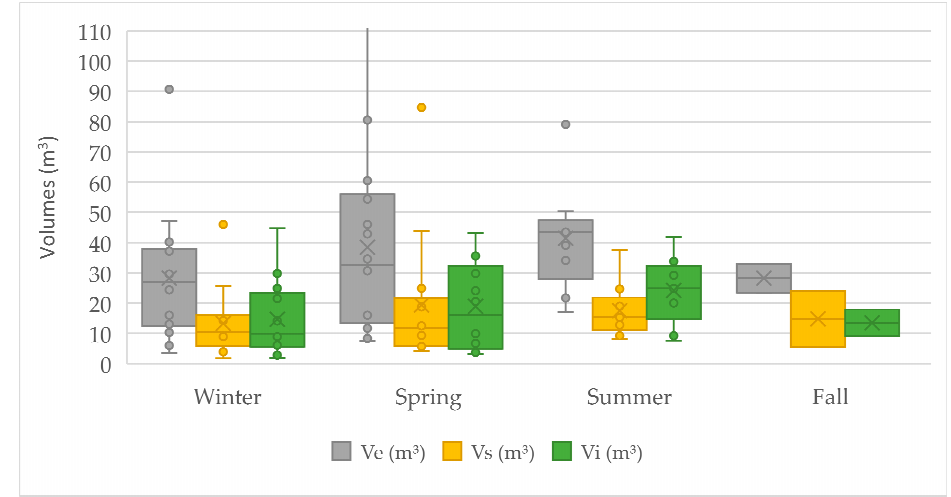
Figure 5. Balance of volumes in the swale inlet, outlet, and infiltrated volume distribution. The average infiltrated volume over the monitoring period is 18.3 m 3 . The average per season is more variable, with a volume of 24 m 3 in summer (Figure 5); the lowest seasonal average is detected in winter and fall (14.7 and 13.5 m 3 ), and an intermediate value of 19 m 3 is detected in spring. The inflow volume is much higher in summer (41 m 3 ) than in winter (28 m 3 ) and similar to spring (38 m 3 ). According to [42], precipitation characteristics influence infiltration structures in two ways. The most efficient aquifer recharge and infiltration events are generated by stratiform precipitation (when soil saturation increases without generation of flow) and intense convective precipitation events, in which recharge rates are more inefficient due to both an excess saturation with the flow generation and an increase in the evapotranspiration rate. That was not observed in Florian ó polis. Even with major intensities in summer, the average infiltrate volume is higher in this season. This is probably due to the fact that the infiltration capacity of the coastal soil of Campeche in Florianópolis is high and the aquifer, although shallow, is large. Thus, soil infiltration capacity frequently does not present an impediment to infiltration even in hight-intensity precipitations. It is as if the higher volume of available precipitation in summer is able to force more infiltration in the soil, which does not present resistance to infiltration due to its sandy characteristic. The large aquifer of Campeche absorbs and distributes the infiltrated water from the swale relatively fast.